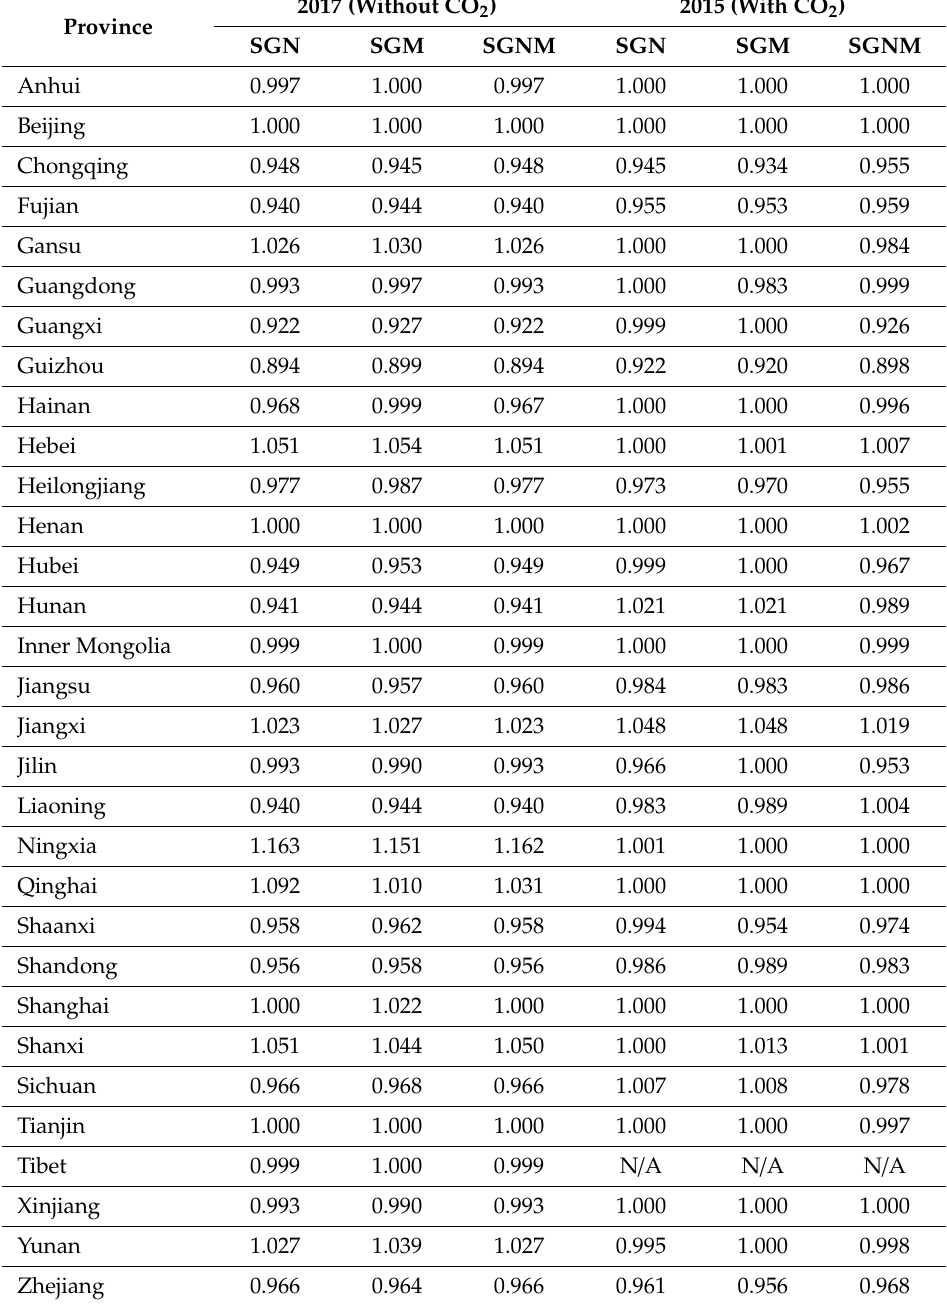
Table 2. Provincial-level SGN, SGM and SGNM for 2017 and 2015.